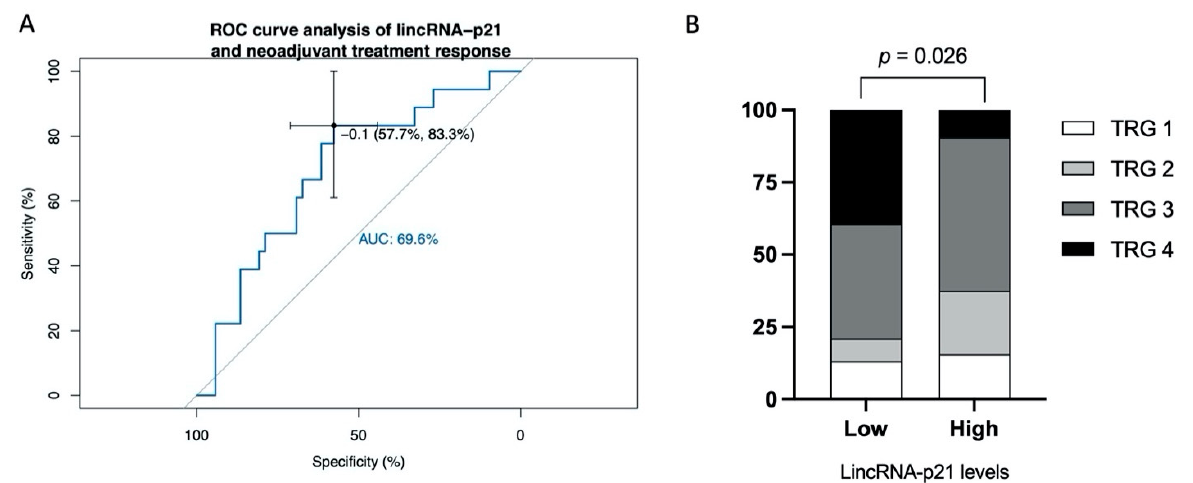
Figure 2. Predictive analyses for response to neoadjuvant treatment. ( A ) ROC curve analyses to evaluate the potential utility of lincRNA-p21 to distinguish patients with maximum response to neoadjuvant treatment (TRG4) from others (TRG 0–3). ( B ) Percentage of patients with each TRG according to low vs. high lincRNA-p21 expression, dichotomized using optimum truncation point obtained in the ROC curve analysis ( − 0.1). AUC, area under the curve. TRG, tumor regression grade.